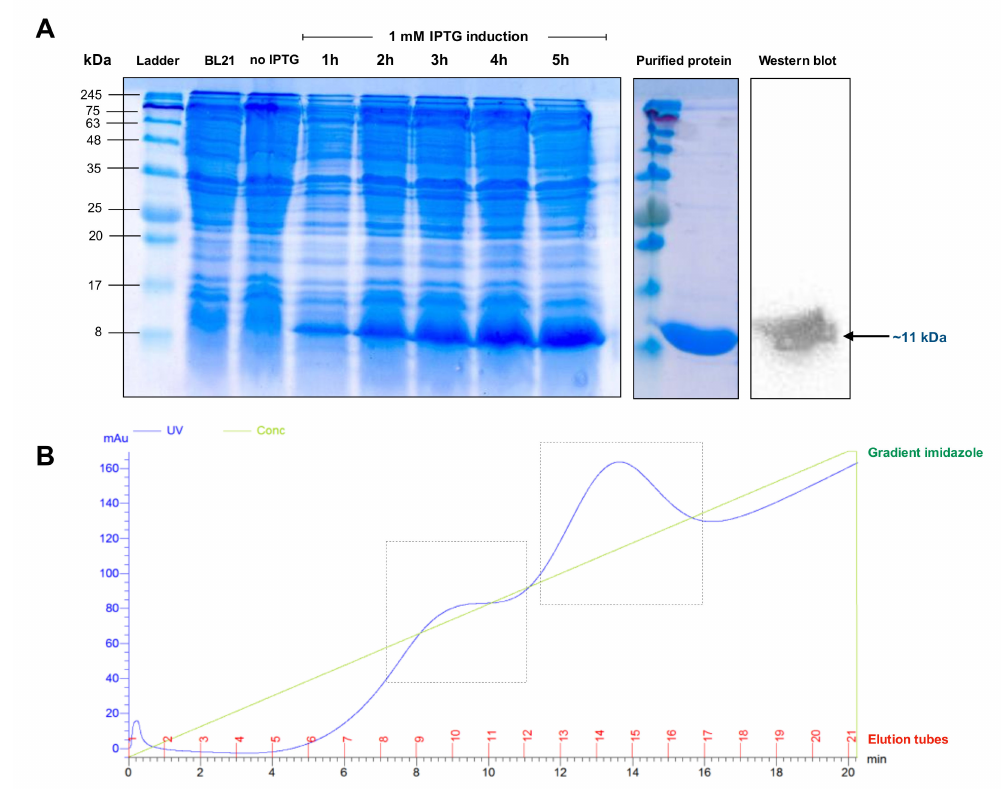
Figure 3. Overexpression, purification, and Western blot analysis of the C µ 1 protein of the IgM heavy chain of bighead catfish ( A ) and chromatogram for purification of the C µ 1 protein using Ni-NTA a ffi nity in di ff erent continuous linear gradients of imidazole ( B